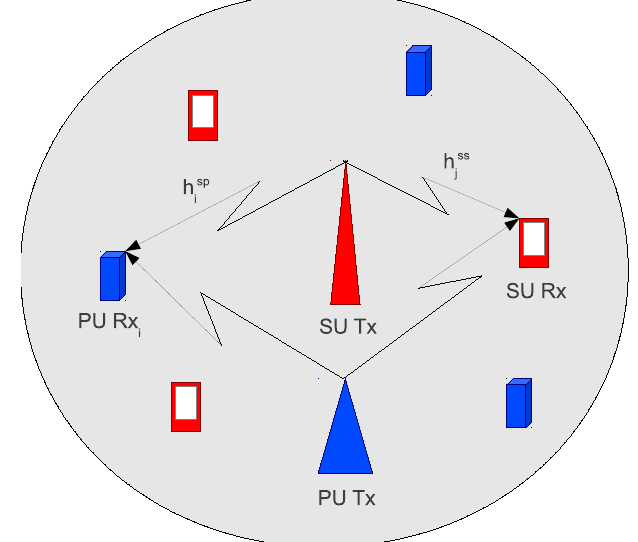
Figure 1. A typical scenario of primary and secondary user communications in a geographic area, where primary and secondary users co-exist in side-by-side bands. They cause adjacent channel interference to each